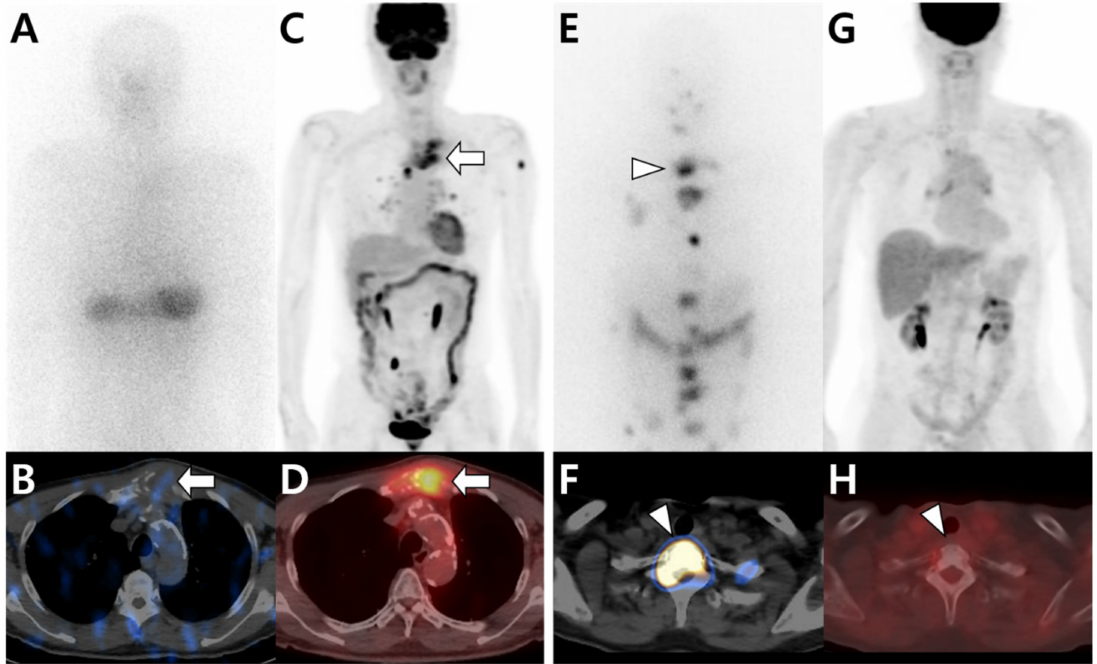
Figure 3. Different tracer avidities in bone metastases from papillary thyroid carcinoma (PTC) according to differentiation status. ( A – D ) A 79-year-old male patient with PTC. 131 I whole-body scan ( A ) and single-photon emission computed tomography (SPECT)/computed tomography (CT) ( B ) show little iodine uptake in metastatic lesions located in the sternum (arrow). In contrast, 18 F-fluorodeoxyglucose ( 18 F-FDG) positron emission tomography (PET)/CT ( C , D ) shows intense FDG uptake in the sternum (arrow). ( E – H ) A 66-year-old female patient with PTC. 131 I whole-body scan ( E ) and SPECT/CT ( F ) show multiple iodine uptake in metastatic bone lesions, including those in the T1 vertebra (arrowhead). However, 18 F- FDG PET/CT ( G , H ) shows no significant uptake at the same